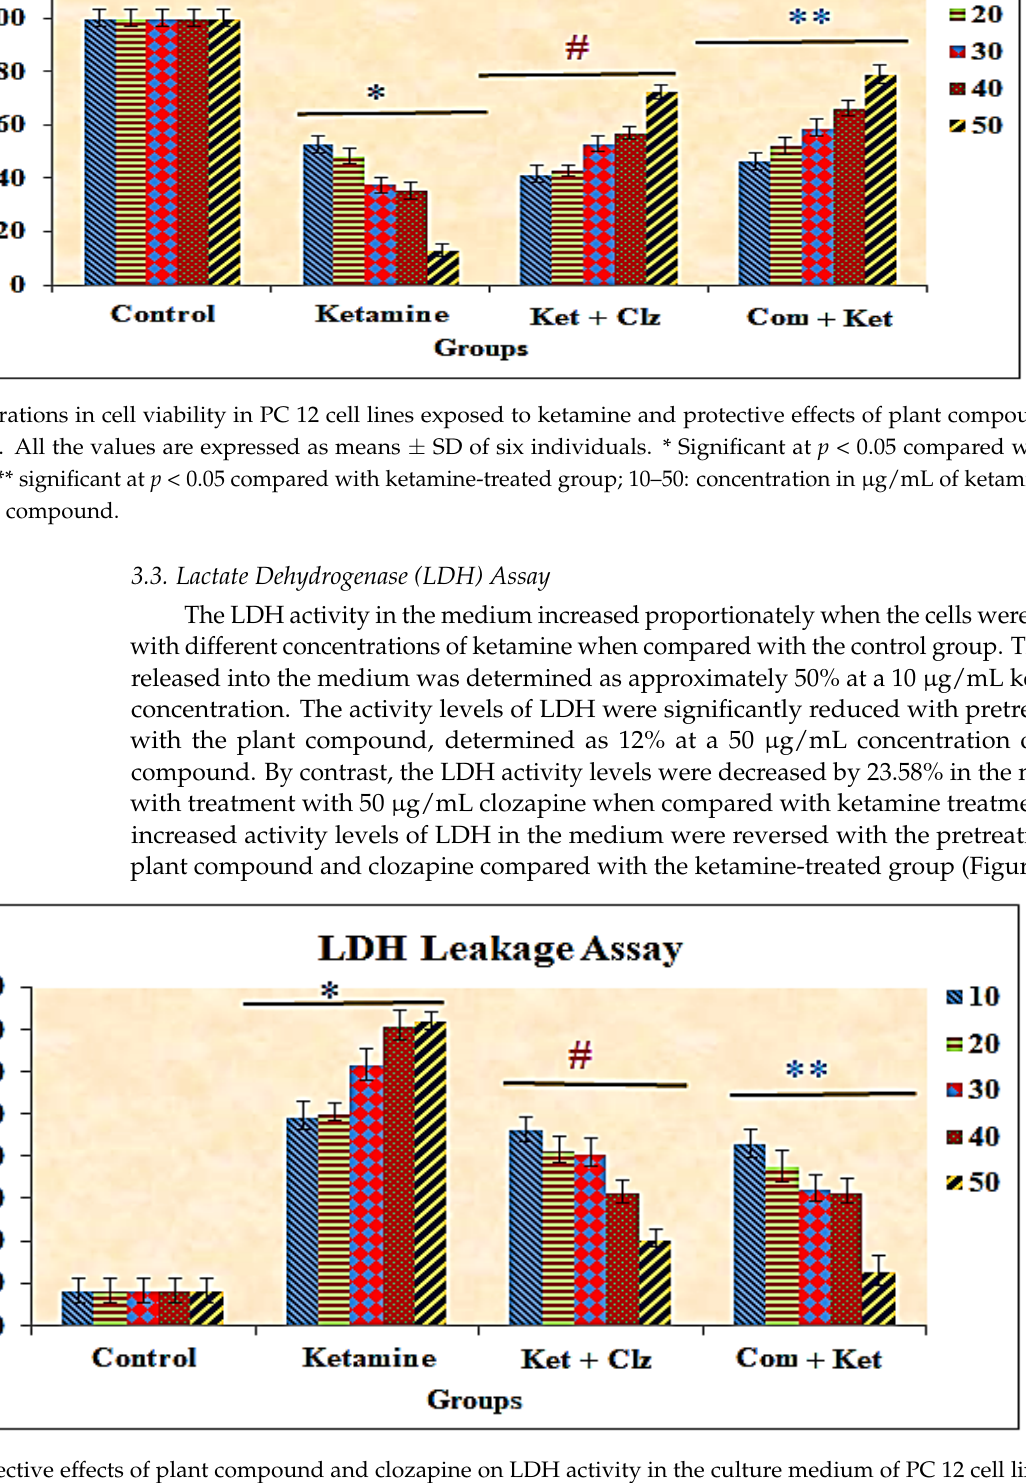
Figure 2. Effect of plant compound and clozapine on cell viability of PC 12 cell lines during in vitro ketamine treatment. ( A ) PC 12 cell line (control). ( B ) PC 12 cell line treated with ketamine for 12 h. ( C ) PC 12 cell line treated with clozapine for 2 h after ketamine treatment. ( D ) PC 12 cell line treated with plant compound for 2 h before ketamine treatment. Scale: 100 μ m.